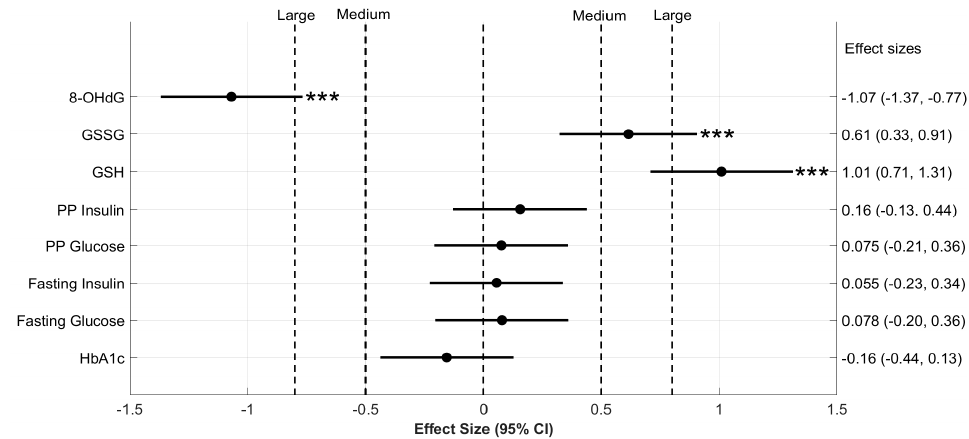
Figure 2. The effect size of changes in blood biochemical parameters. Six-month changes in the biochemical parameters of D and DG groups were compared here on a forest plot with effect size and corresponding 95% confidence intervals (CI). Effect size (Cohen’s d) calculated between 6-month changes in the concentration of biochemical variables are denoted on the x -axis. The group-wise means of 6-month changes in the concentration of these variables were compared using two-sample permutation tests. The significance of these comparisons is denoted by the p values mentioned to the right of horizontal lines for CI. Significance level is *** p < 0.001 for respective comparisons. Effect size takes either a positive or negative sign based on the direction of change: a positive effect size increases towards the right and a negative effect towards the left. Vertical dotted lines represent different classifications of effect size. In particular, “Medium” effects are labeled at 0.5 and − 0.5, and “Large” effects at 0.8 and − 0.8. Abbreviations used here are, HbA1c—glycated hemoglobin, GSH—reduced glutathione, PP glucose—postprandial glucose, PP insulin—postprandial insulin, and 8 ‐ OHdG—8 ‐ hydroxy ‐ 2 ‐ deoxy guanosine.